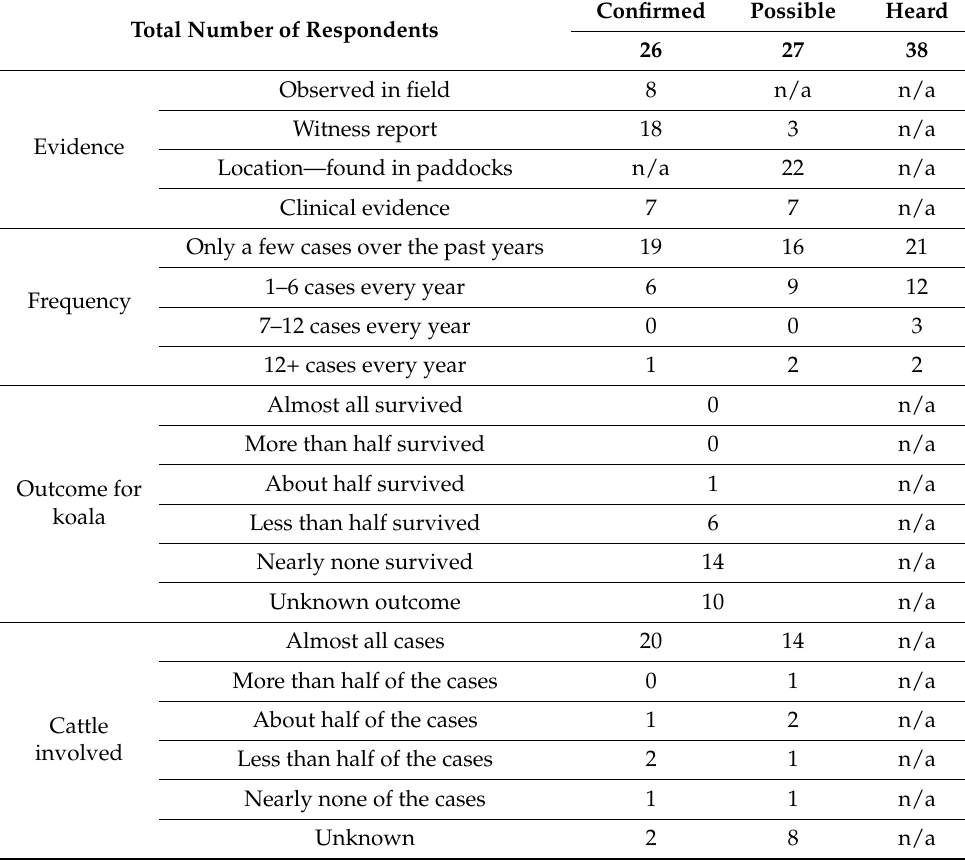
Table 1. Number of survey respondents who had seen confirmed or possible koala injuries/deaths caused by livestock, and those who had only heard of anecdotal incidents, as well as their evidence, frequency, outcome and cattle involvement. The koala outcome results refer to all livestock-related incidents (Confirmed and Possible